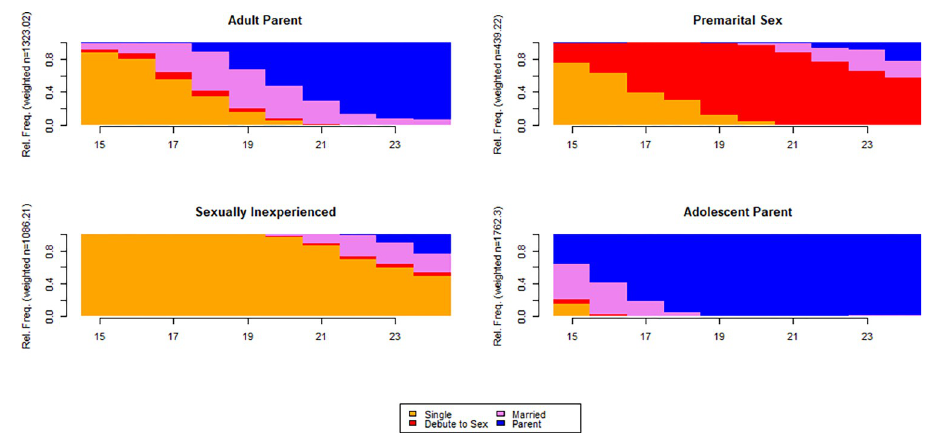
Fig 2. Typology of youths reproductive trajectories, Oromia–Ethiopia.